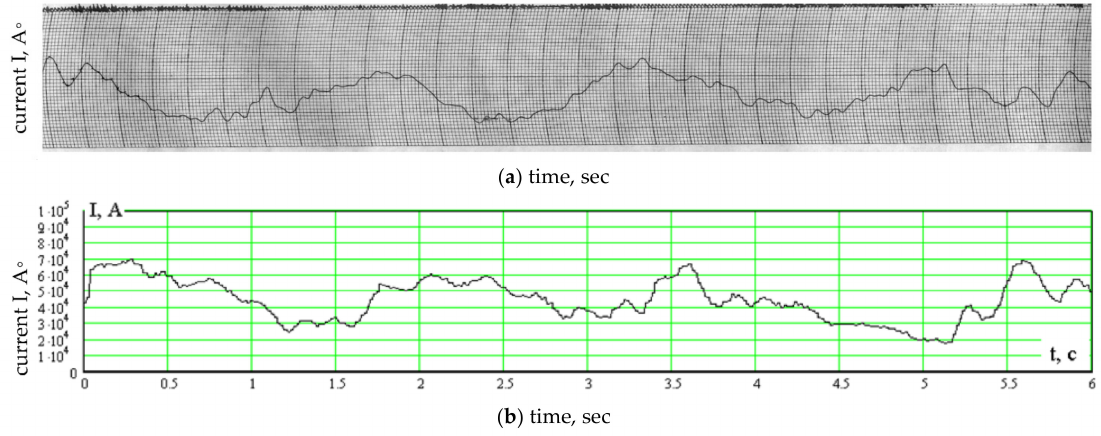
Figure 15. The dependences of the phase B current change for the melting start stage obtained experimentally ( a ) and with the help of a model with tabular volt-ampere characteristics and the application of the 4-th order Runge-Kutta method ( b ).